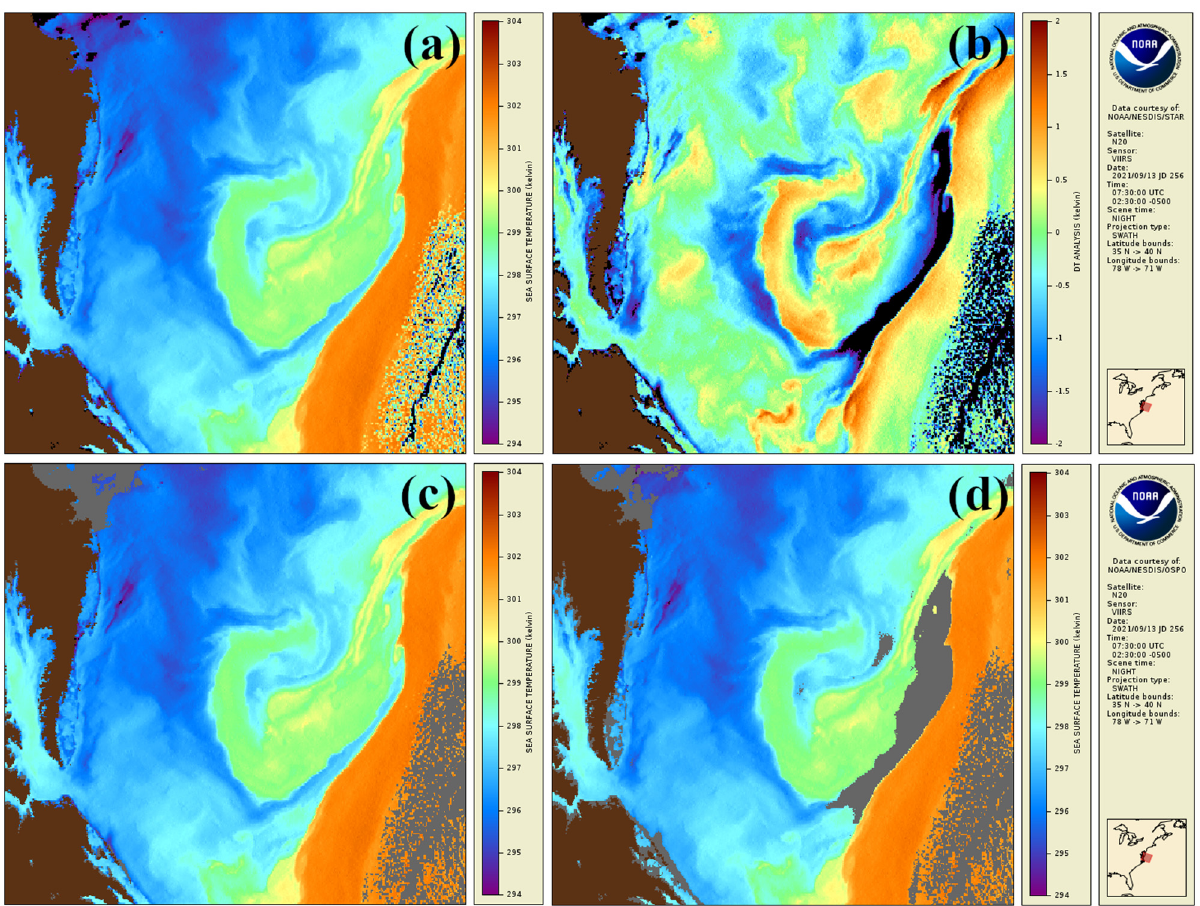
Figure 3. ACSPO N20 VIIRS nighttime L2P SST imagery over the Chesapeake Bay on 13 September 2021. ( a ) ACSPO V2.80 all-sky ‘subskin’ SST (no mask applied); ( b ) Δ SST = ‘subskin’ − CMC L4 SST (pixels with Δ SST < − 2 K are shown in black); ( c ) same as ( a ) but with the V2.80 mask applied (gray pixels); ( d ) same as ( c ) except the mask is now from V2.61. Note that over-screening of cold Δ SSTs is significantly reduced in V2.80.